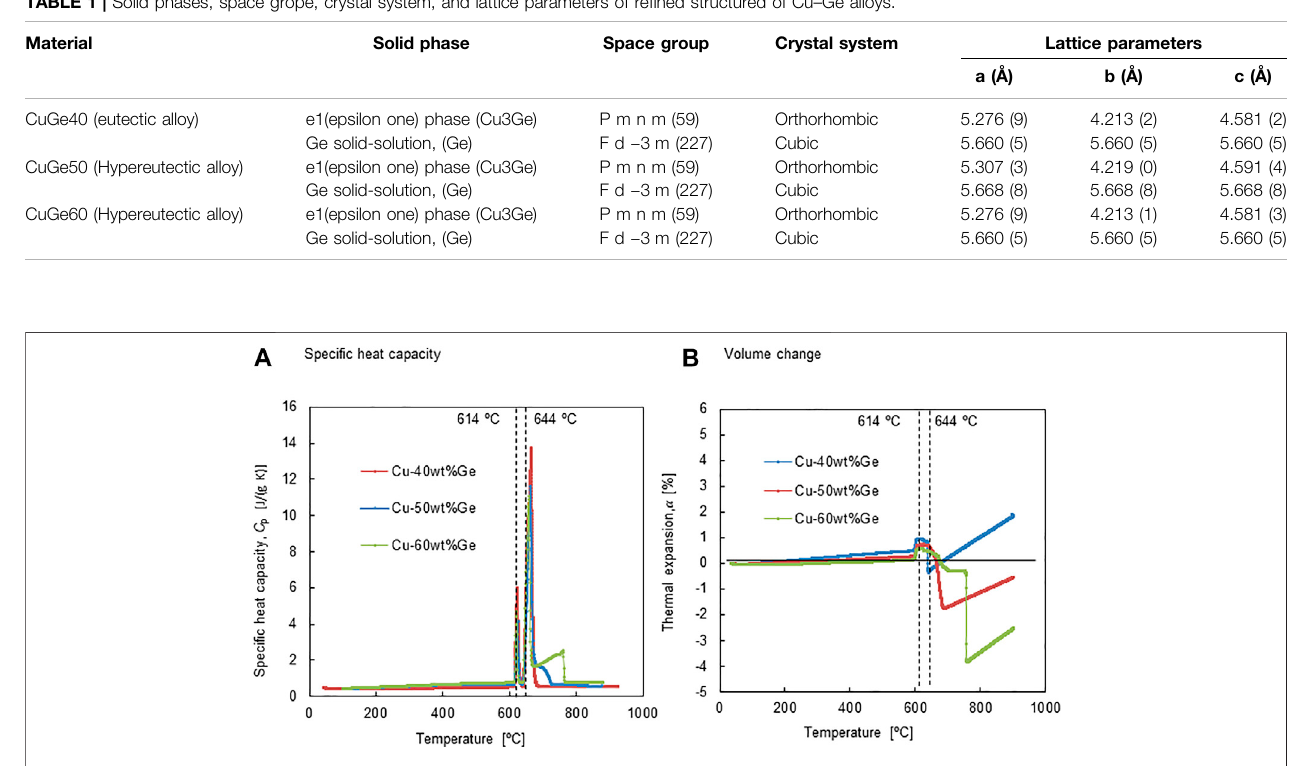
FIGURE 4 | (A) speci fi c heat capacity and (B) volume change as a function of temperature for all the alloys.